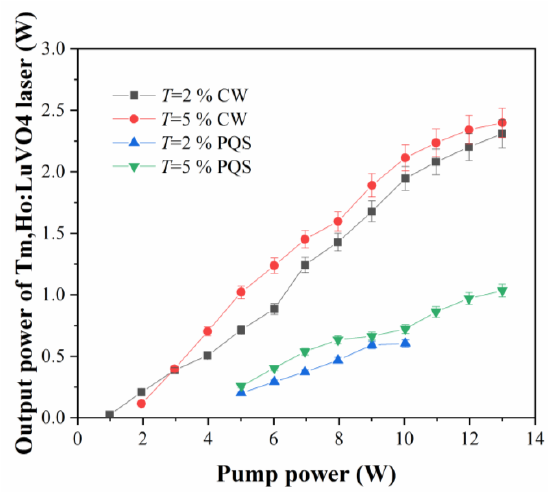
Figure 2. Output power of Tm,Ho:LuVO 4 laser in CW and PQS mode operations verse the pump power.